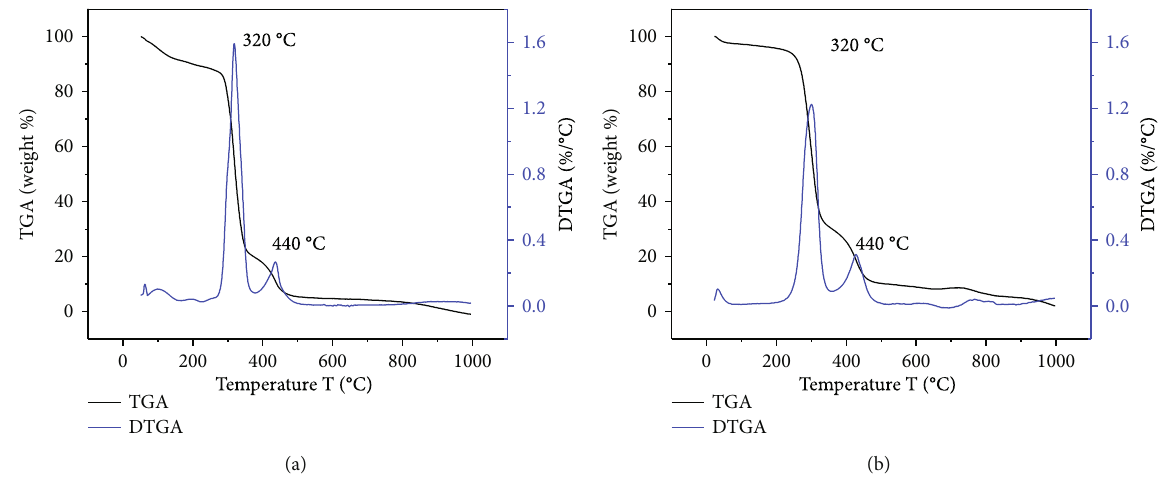
Figure 5: (a) Thermogravimetric (TGA) and di ff erential-thermogravimetric (DTGA) curves for pure poly(vinyl alcohol) (PVA) fi bers (PF75) are shown in black and blue, respectively. (b) TGA results for composite fi bers (CF75) comprising of the layered double hydroxide- fi lled PVA fi bers.